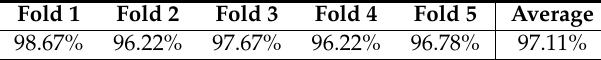
Figure 10. The confusion matrix of accuracy. Table 8. The result of 5-fold cross